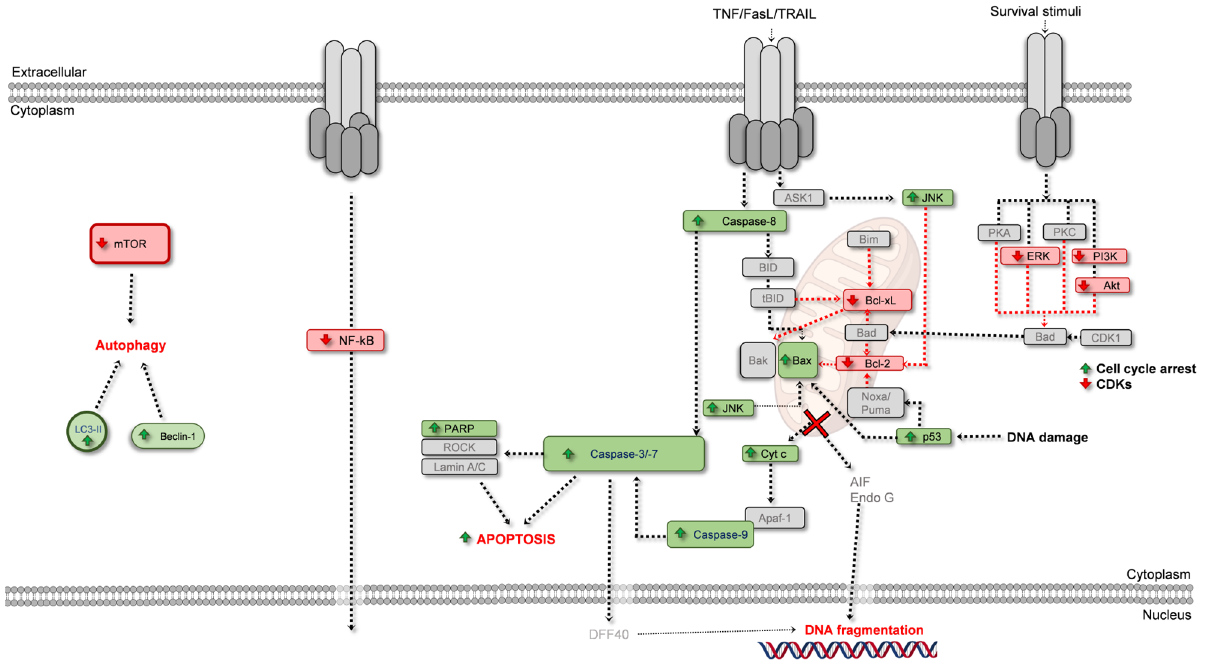
Figure 6. Main proteins and cellular pathways involved in phytochemicals’ anti-tumoral activity. Downregulation (red arrows) and upregulation (green arrows).